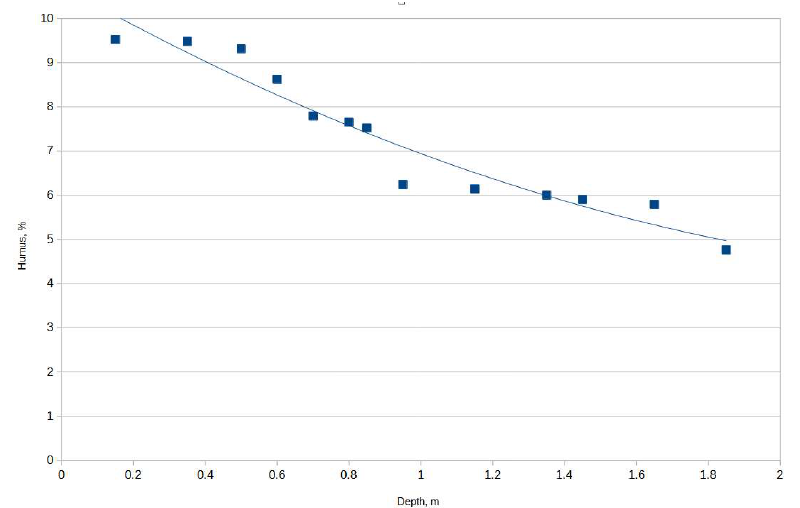
Figure 6. Humus content in the section 1 of Mohylna 3. Analysis by H.P. Zadverniuk. Elaboration— DK.